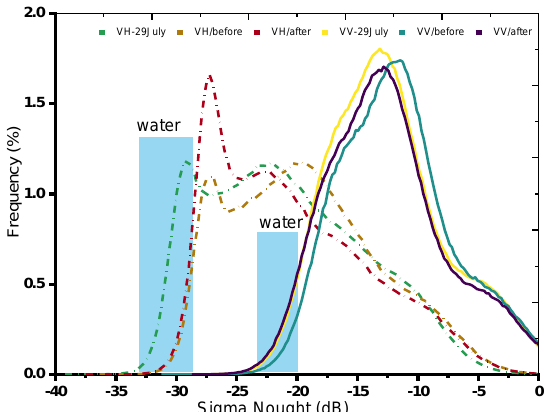
Figure 4. Histograms for water backscattering for VV and VH polarized Sentinel-1 data sets within the validation area in Yazd city (during 29 to 30 July 2022).